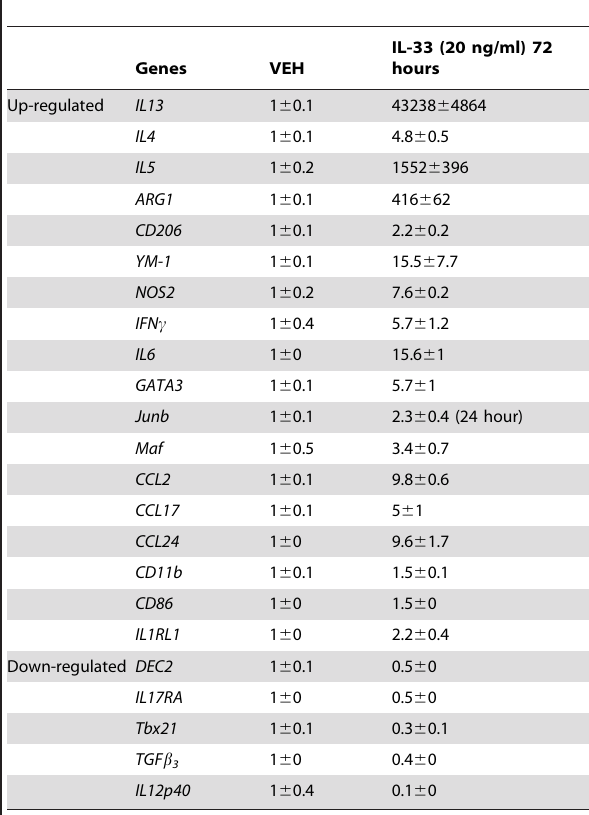
BMDM: bone marrow-derived macrophages.